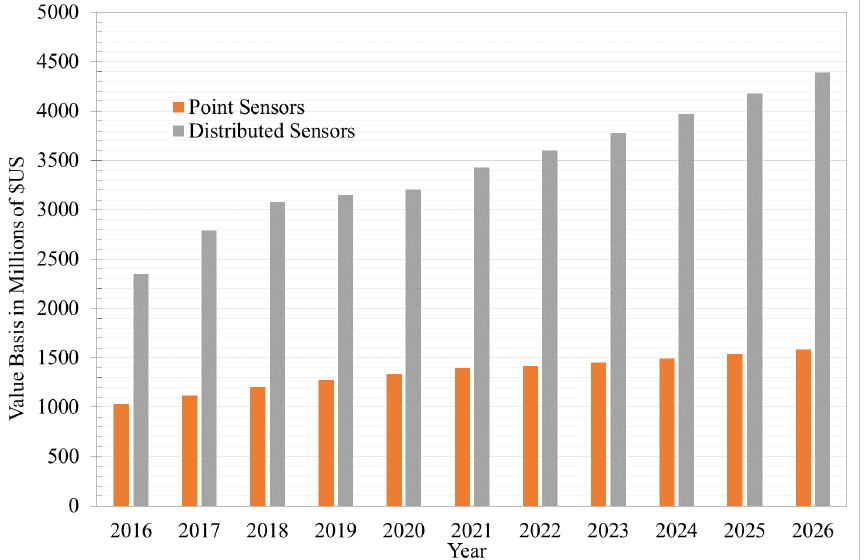
Figure 3. Global consumption value of fiber optic sensors market forecast. Reproduced with permission from [39], Copyright EletroniCast Consultants,